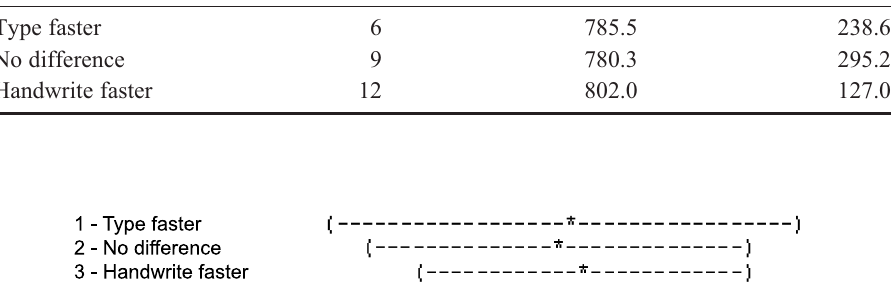
Figure 1. Individual 95 confidence intervals for means based on pooled standard deviations. This may indicate that the amount written in an examination is only partially dependent on the speed of writing/typing – one could speculate perhaps that it depends also on fluency of thought.